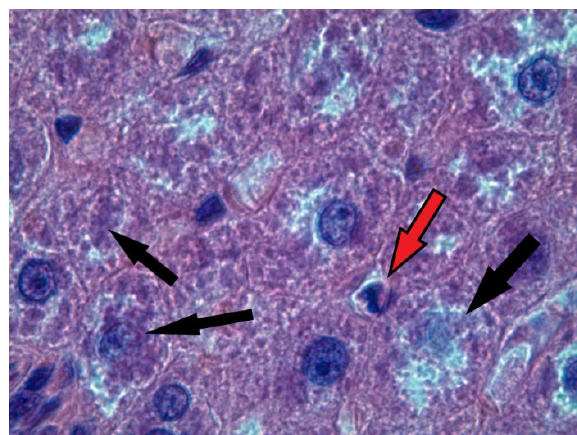
Figure 2. Liver of rat of EtOH + CL group. Hematoxylin and eosin staining, ×1000. Red arrow indicates hepatocyte in a state of apoptosis; black arrows—hepatocytes in a state of necrosis.